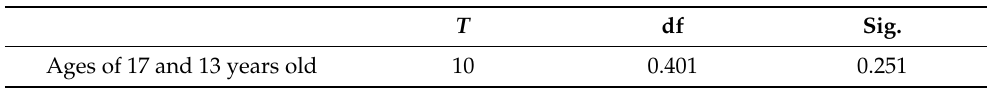
Table 10. Paired t -test results for the average amounts of C stored in plants under D. polyphylla stands for two age classes. T df